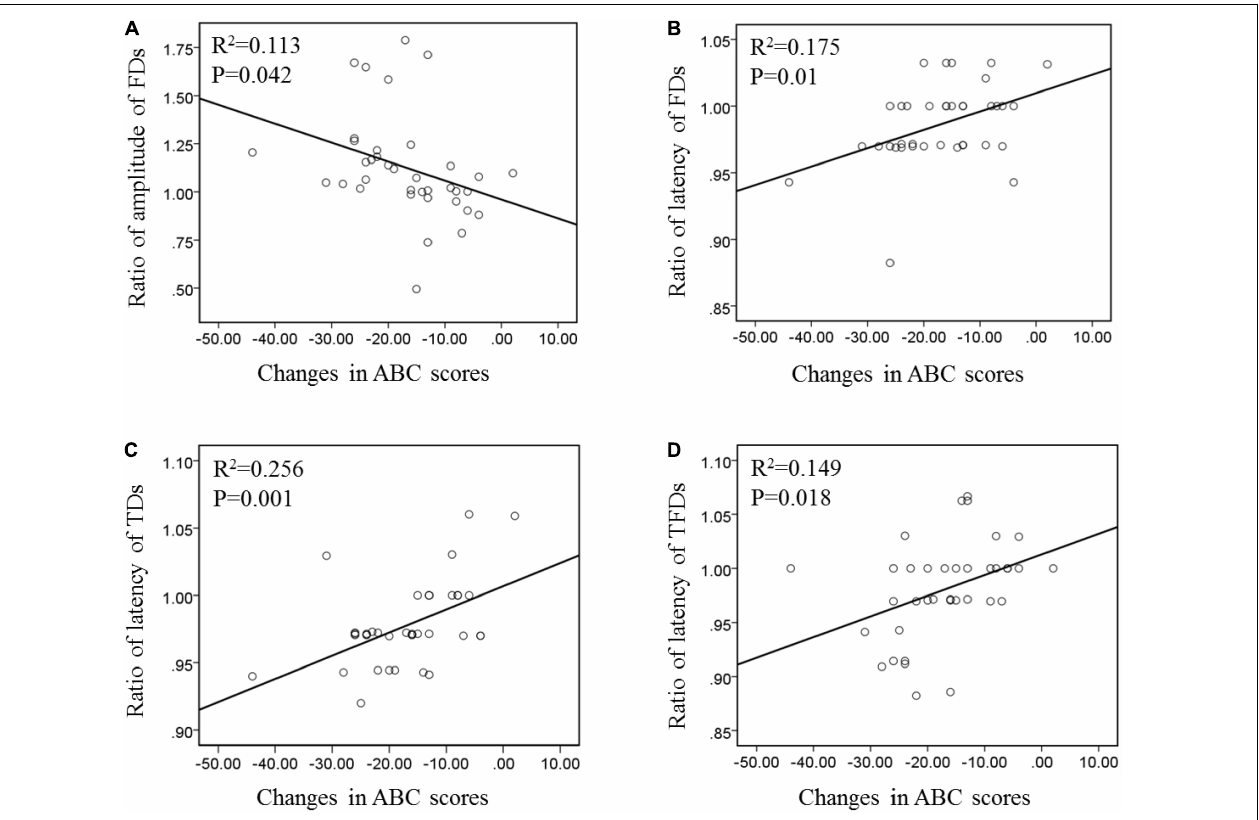
FIGURE 4 | Correlation of the changes between MMN and behavior ability under the three types of deviation stimuli pre- and post-tDCS. (A) Correlation between the amplitude of FDS and ABC. (B) Correlation between the latency of FDS and ABC. (C) Correlation between the amplitude of TDS and ABC. (D) Correlation between the amplitude of TFDS and